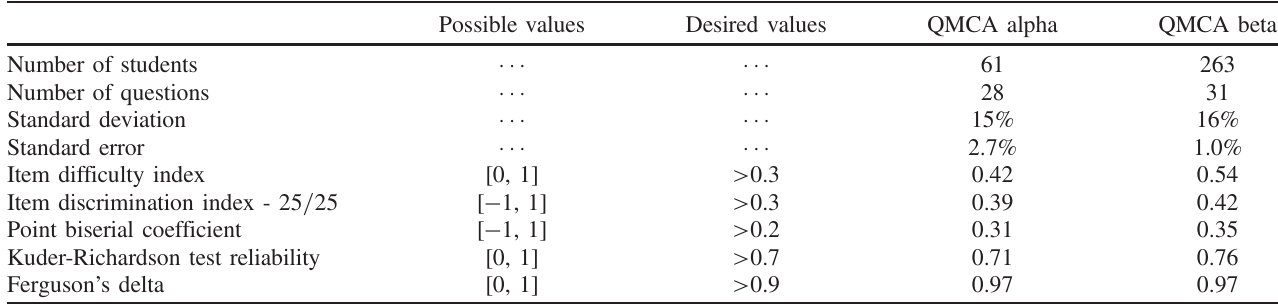
TABLE V. A summary of statistical test results for both alpha and beta versions of